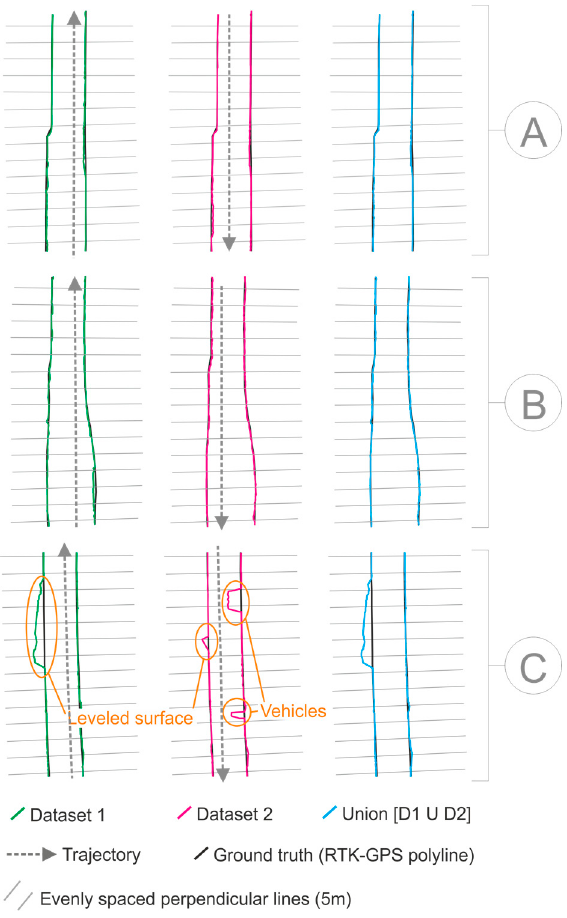
Figure 11. Smoothed polylines from Dataset 1, Dataset 2, and the union of them in three different sections ( A , B , and C ) of the test stretch of road.